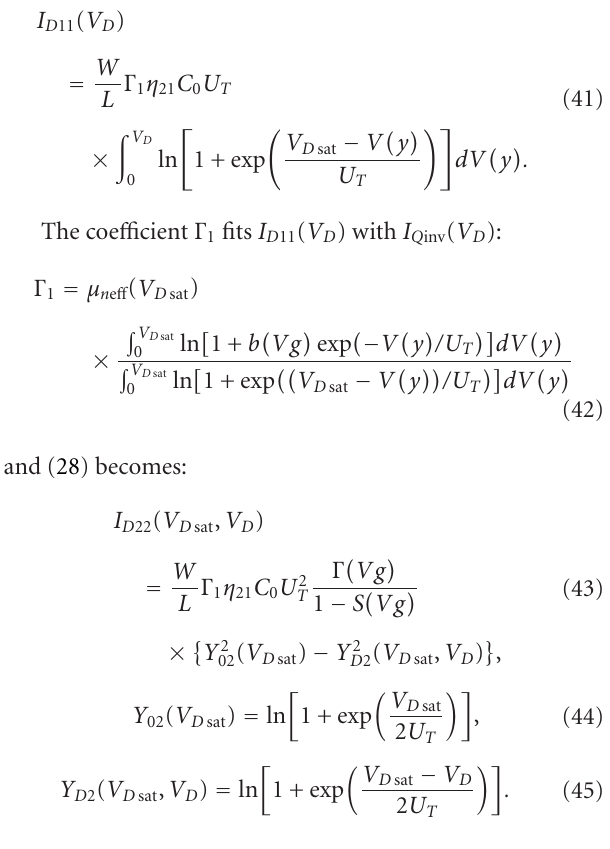
Figure 9: ( I D , V D ) plots with velocity saturation. (A) [17] ( β = 1), (B) mobility correction with β = 2, (C) [20], and (D) saturation current I D sat = WQ inv v sat .